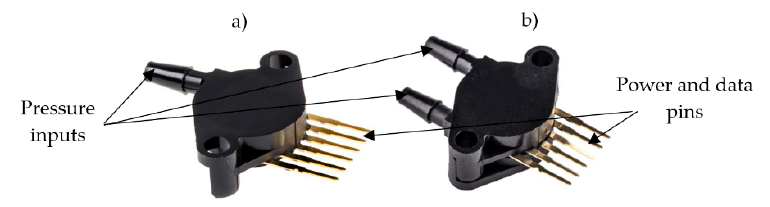
Figure 3. Low-cost pressure sensors used in the acoustic bench. ( a ) MPX5100AP sensor; ( b ) MPX5050DP sensor.